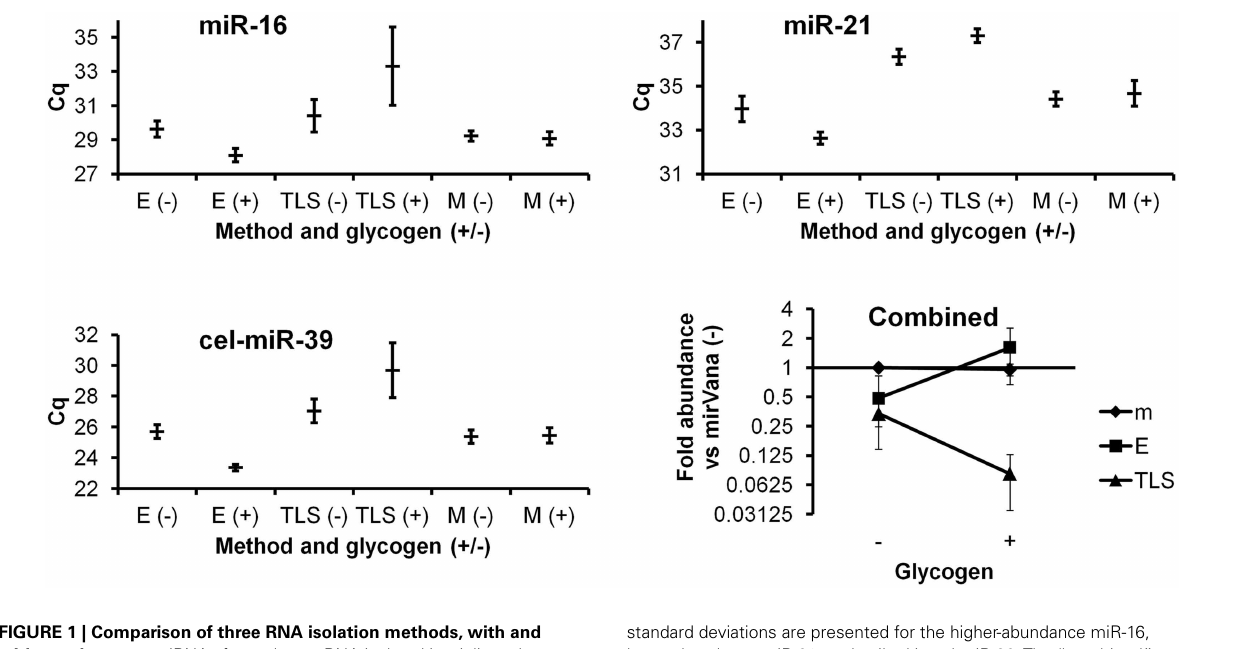
standard deviations are presented for the higher-abundance miR-16, lower-abundance miR-21, and spiked-in cel-miR-39.The “combined” panel shows mean apparent combined abundance of miRNAs in samples isolated by the mirVana no-glycogen method set equal to one. Fold abundance (from deltaCq method) is displayed with